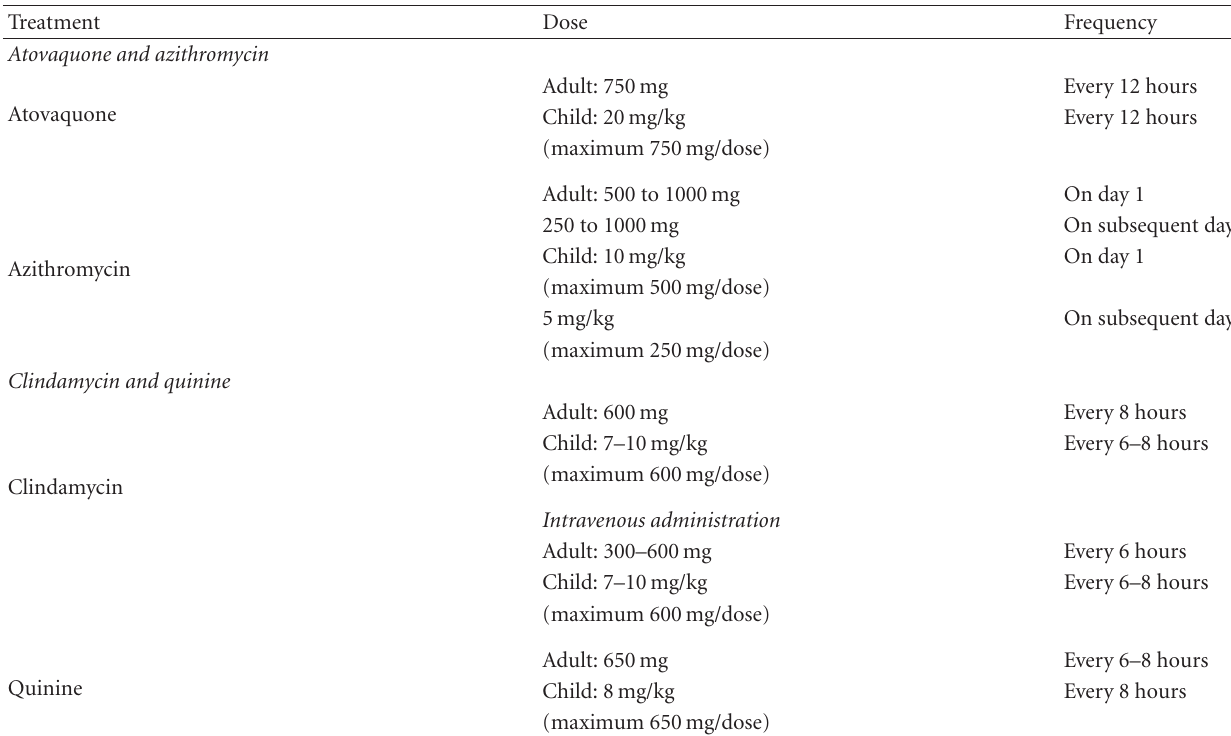
Table 3: Treatment of